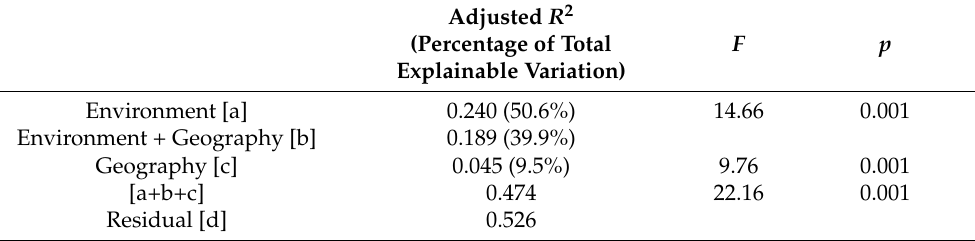
Figure 5. Linear regression plots of nine F ST outliers showing significant correlation relationships of allele frequency with population mean F ST . Pearson’s correlation test results are reported in Table S8. Table 6. The percentage of variation (adjusted R 2 )-explained outlier variation and variation accounted for by non-geographically structured environmental variables [a], shared (geographically structured) environmental variables [b], pure geographic factors [c], and undetermined component [d] analyzed based on variations in 26 F ST outliers. Fraction [a+b+c] represents total explainable